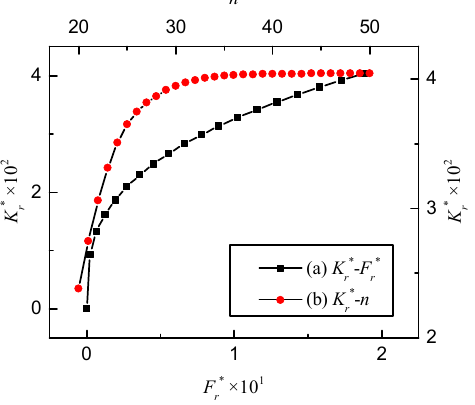
Figure 5. Variation of dimensionless normal contact stiffness due to different parameters: (a) dimen- sionless contact force F ∗ r and (b) frequency index n .